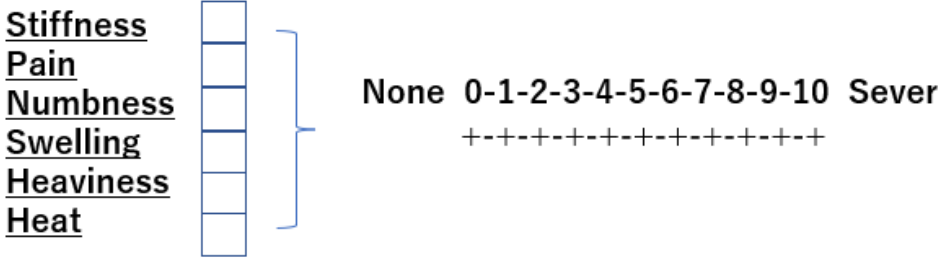
Figure 6. Evaluation sheet of lower leg discomfort. The eleven point rating scale used in the field study to measure the perception of discomfort in the leg. Six items of discomfort on the inspection sheet.